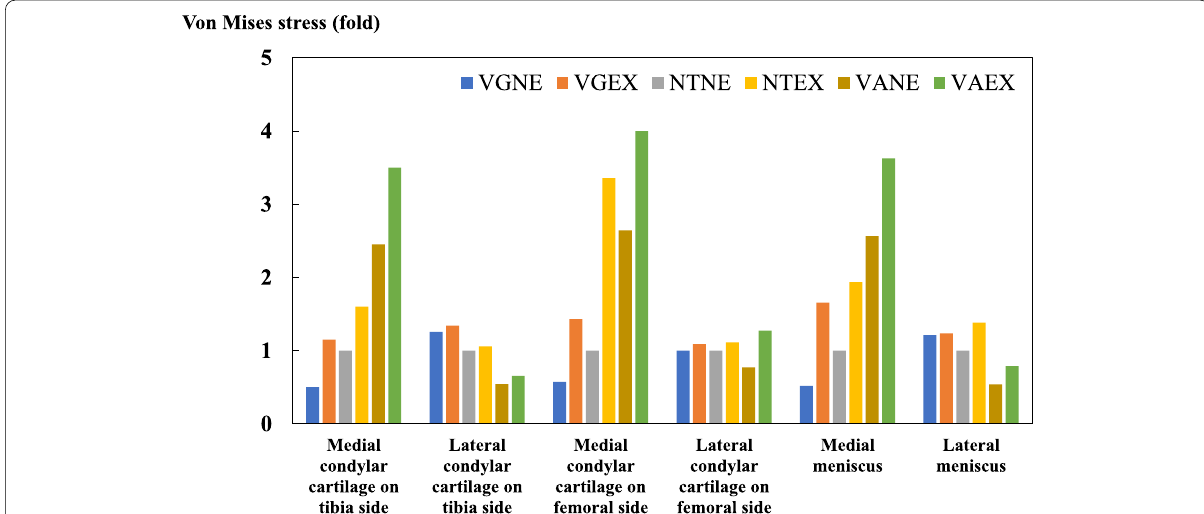
Fig. 6 The mean of the von Mises stress on the condylar cartilage and meniscus, compared with that in an intact model. It was recognized that the tendency for von Mises stress at the medial cartilage and meniscus was increased in the VAEX model, however, the stress applied to the medial compartment in the VGEX model was almost the same as in NTNE. VGNE; valgus and non-extrusion of medial meniscus, VGEX; valgus and extrusion of medial meniscus; NTNE; neutral and non-extrusion of medial meniscus, NTEX; neutral and extrusion of medial meniscus, VANE; varus and non-extrusion of medial meniscus, VAEX; varus and extrusion of medial